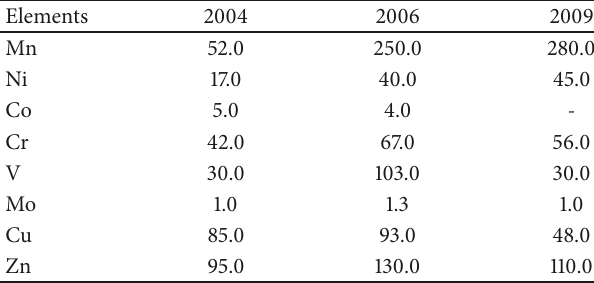
Table 1: Interannual changes in average trace elements content in total phytoplankton of the Azov Sea, 𝜇 g/g of dry